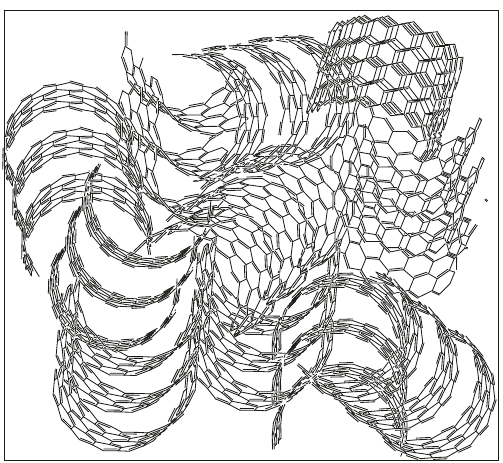
Figure 7: Structure and morphology of ROHG based on Monte Carlo simulations.